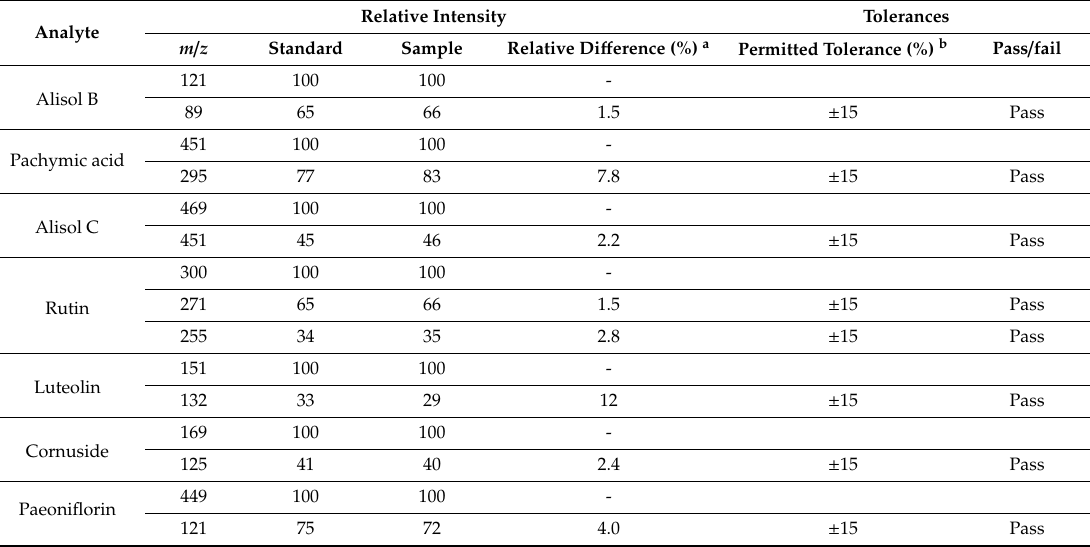
Table 7. The identity confirmation of the analytes.